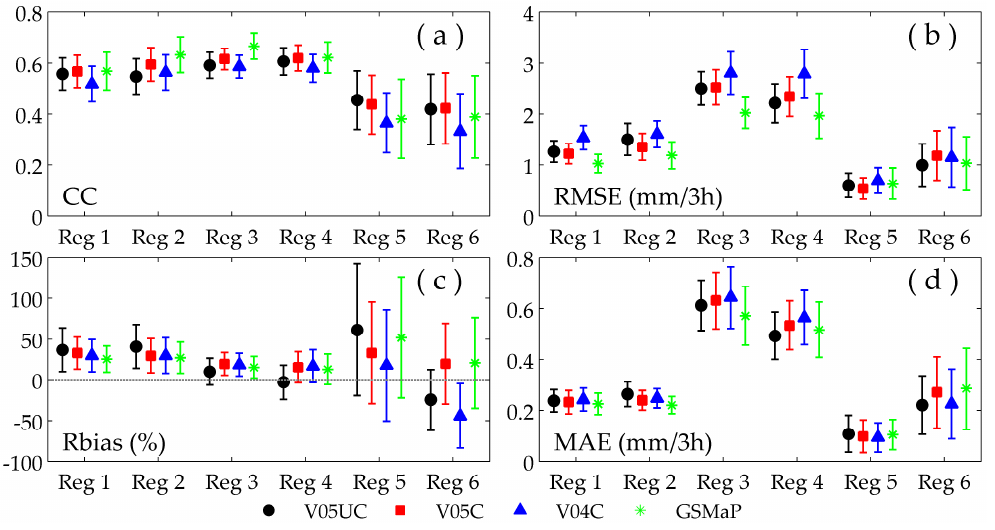
Figure 6. Vertical error bars ( ± σ ) of continuous statistical indices for the four chosen GSPEs at a 3-h time-scale over the six selected regions: ( a ) CC, ( b ) RMSE (mm/3 h), ( c ) Rbias (%) and ( d ) MAE (mm/3 h).